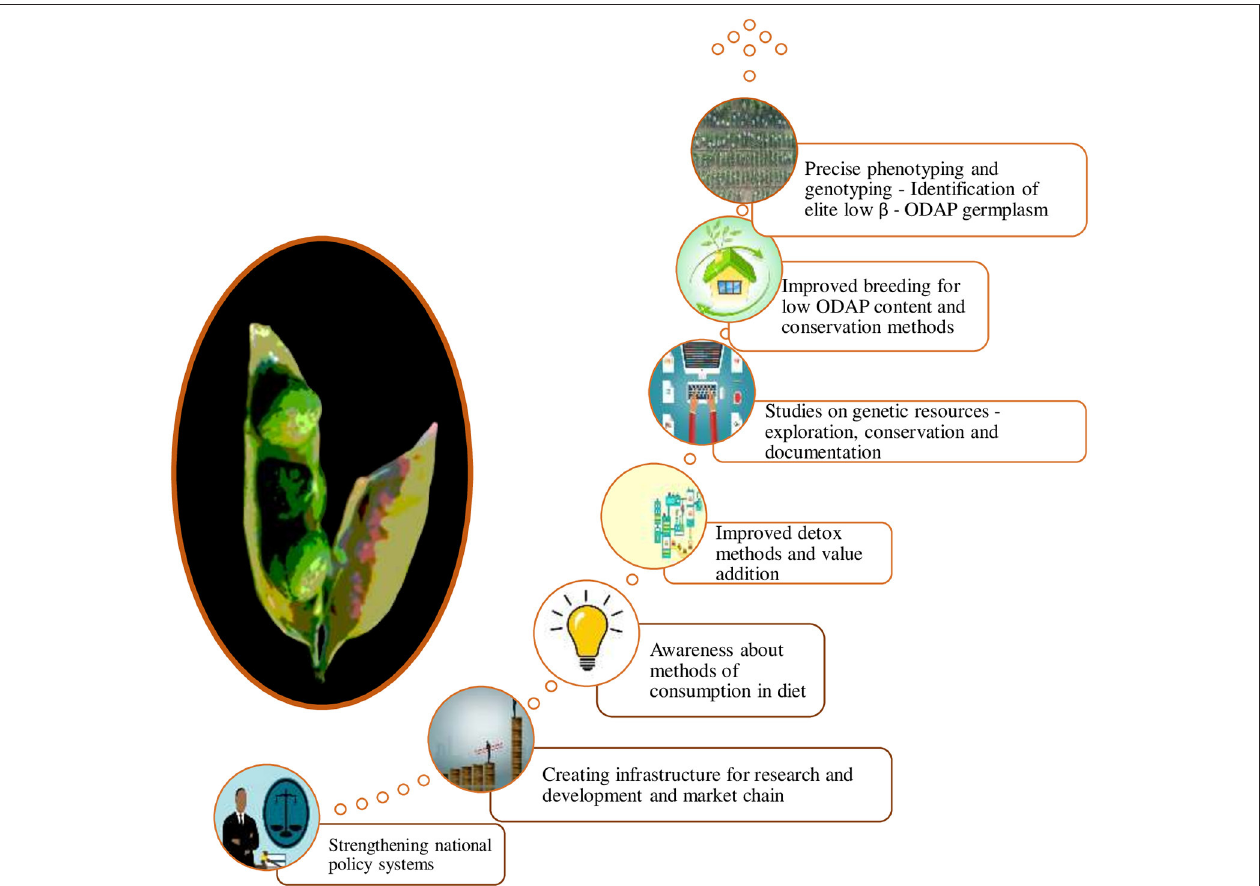
FIGURE 6 | Ways to promote grasspea